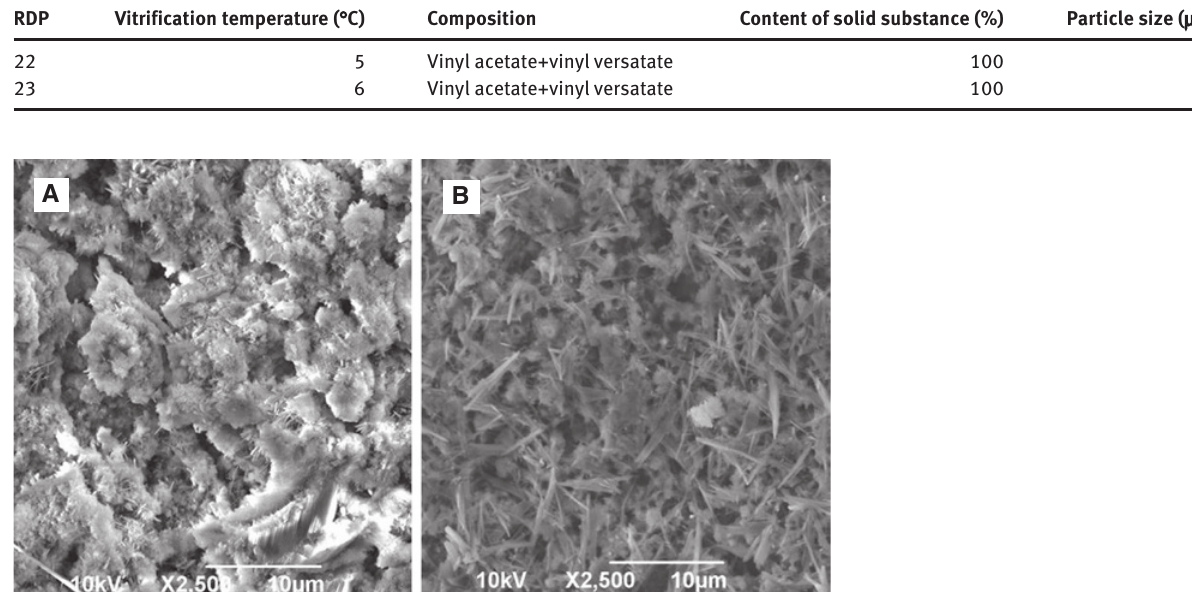
Figure 1: SEM pictures of PCCs without the addition (A) and with maximum amount of nanostructured γ -Al